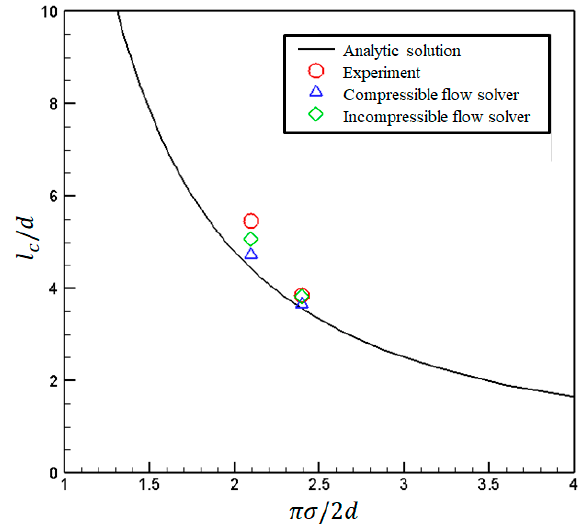
Figure 13. Cavity lengths behind wedge.